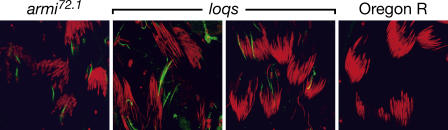
Silencing of Stellate by the dsRNA-Generator Su(Ste) Requires loqs
Testes were stained for DNA (red) and Stellate protein (green). Defects in RNA silencing often lead to accumulation of Stellate protein crystals in testes. For example, the testes from the strong allele armi72.1, but not wild-type Oregon R testes, show Stellate protein staining. Testes from loqs
f00791 males show strong accumulation of Stellate protein, consistent with their significantly impaired fertility.